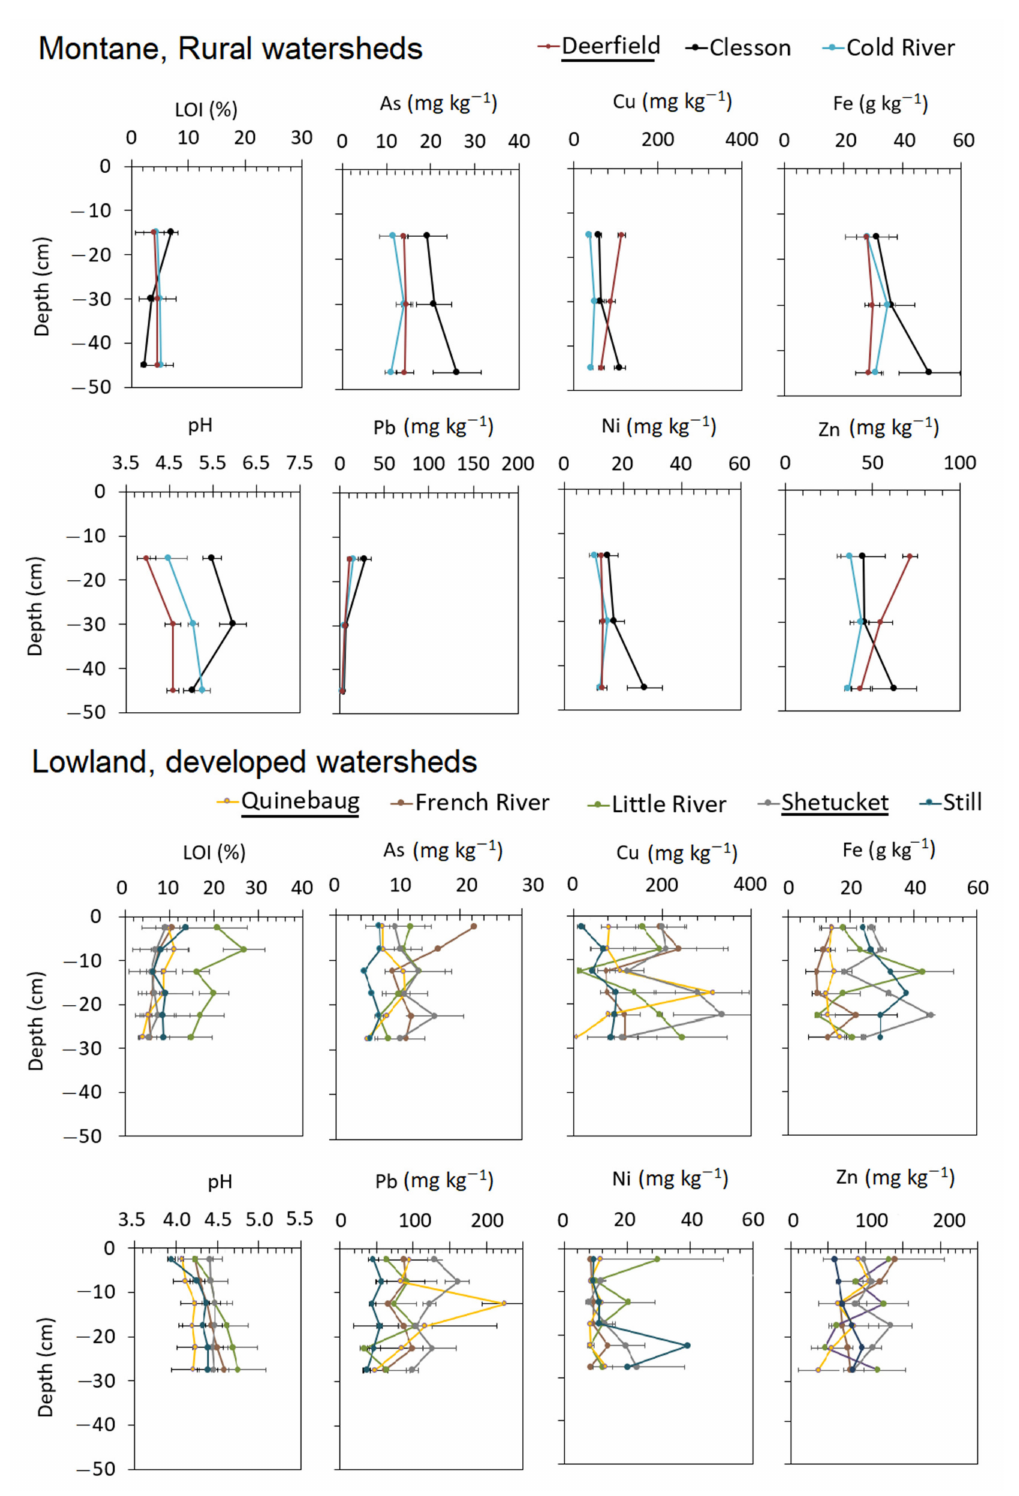
Figure 2. Soil trace element concentrations for upland soil profiles sampled within each of the subwatersheds (N = 3) and in the three main watersheds (Deerfield N = 9, Quinebaug N = 9, Shetucket N = 6). Error bars are the standard errors among the soils at each watershed or